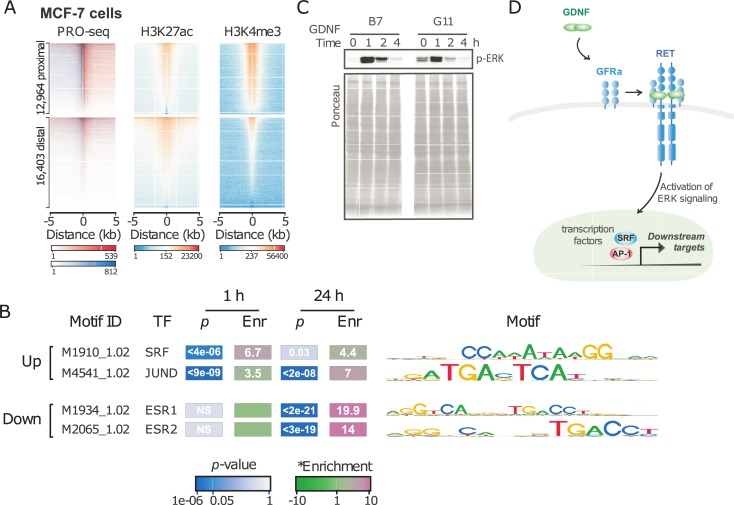
GDNF activates transcriptional regulatory elements.(A) Heatmap depicting PRO-seq, H3K27ac, and H3K4me3 near 1,520 TREs uing dREG from PRO-seq data. (B) Motifs enriched in 1,036 TREs that changed following 1 hr of GDNF treatment compared with TREs that have consistent levels. (C) Immunoblot analysis of p-ERK in B7TamS and G11TamR cells treatment with 10 ng/mL GDNF. (D) Schematic illustration of signaling pathways of tamoxifen resistant MCF-7 cells.